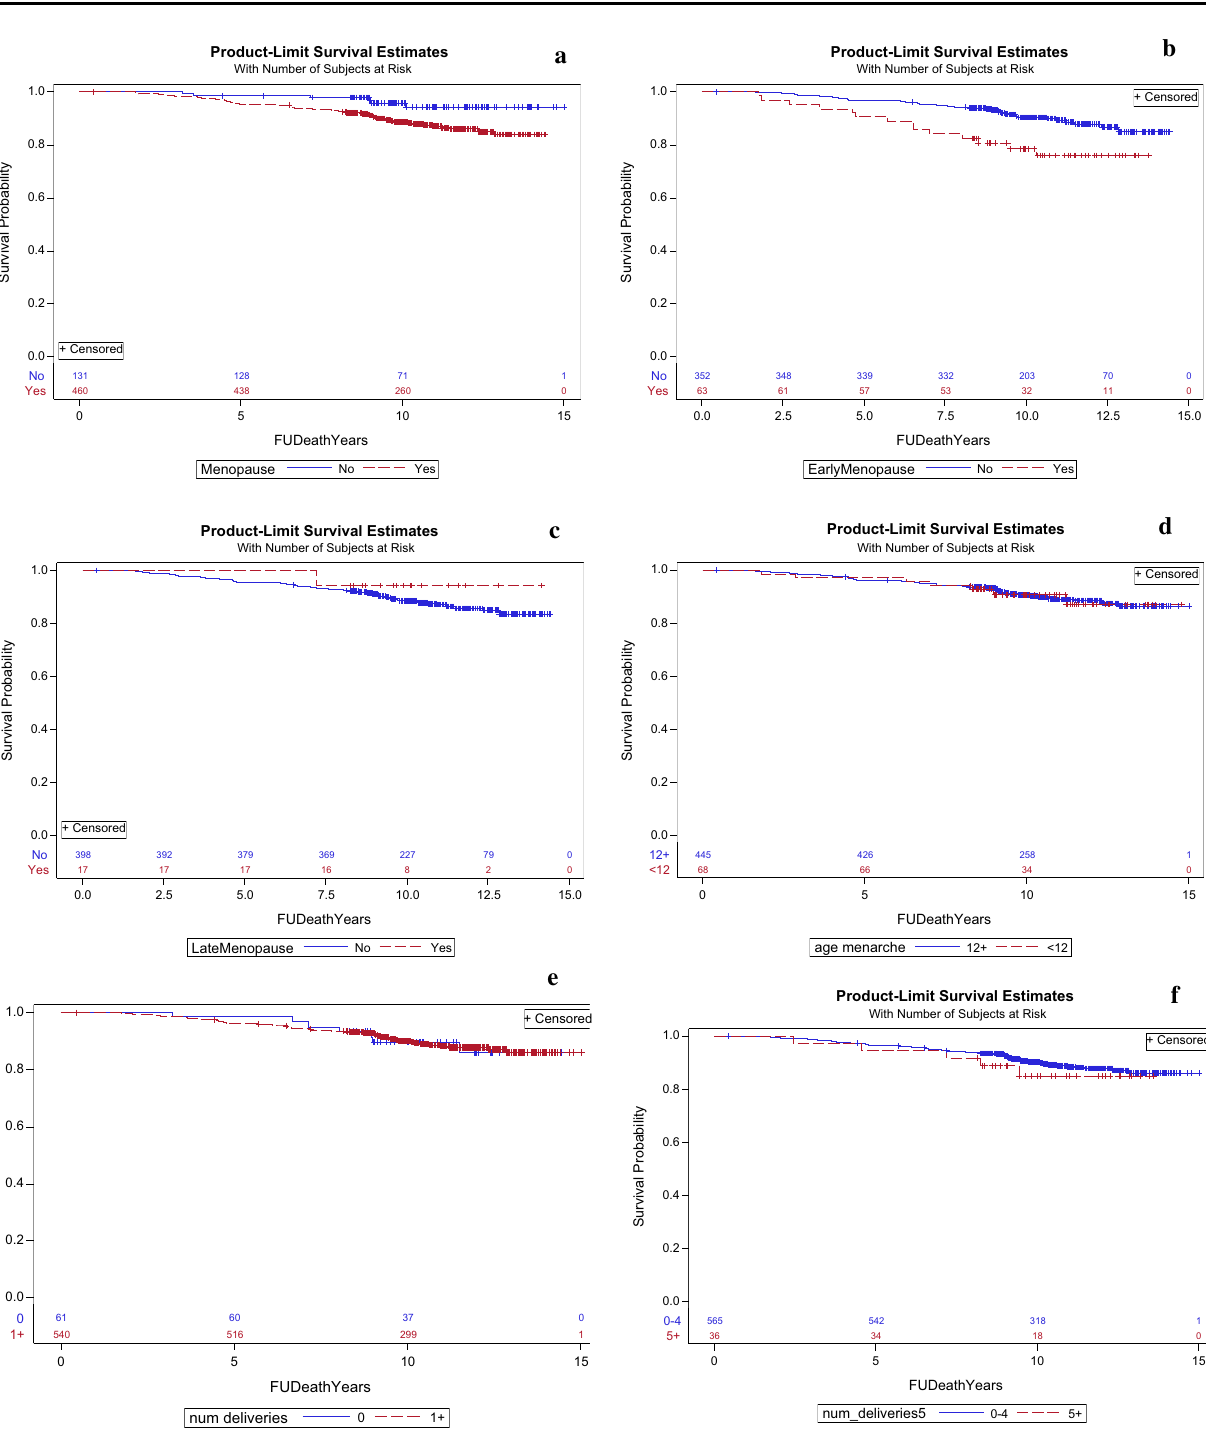
Oncotype RS, a well validated prognostic and predictive factor that is not a subject for inter-laboratory heterogeneity [19], was comparable in all of the evaluated subgroups. No other associations between parity, age of first delivery and age of menopause with tumor characteristics were identified.